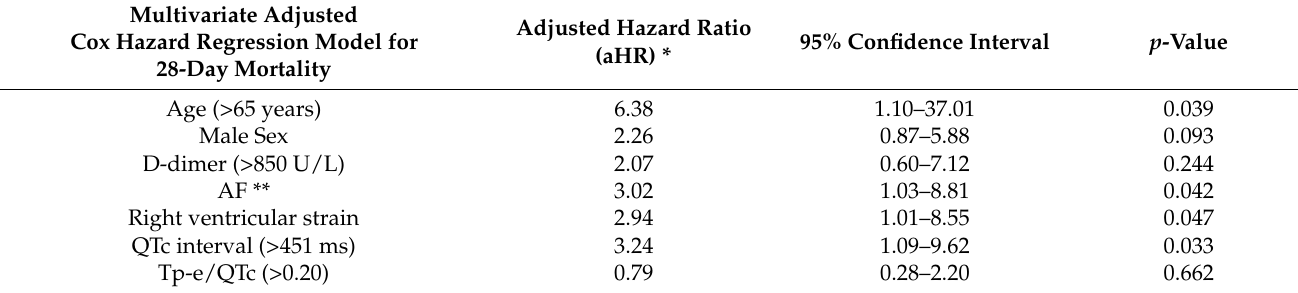
Table 4. Multivariate analysis for 28-day mortality. Multivariate